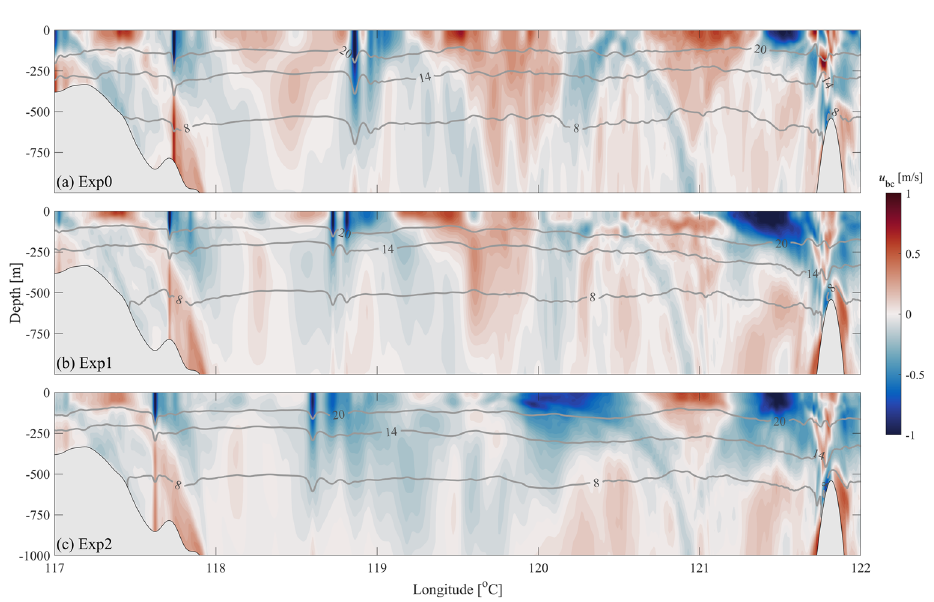
Figure 4. The zonal baroclinic velocities (shadings, units: m/s) of ( a ) Exp0, ( b ) Exp1 and ( c ) Exp2 along the section in Fig. 2 at 14:00:00 April 19, 2007, UTC. Grey contours represent